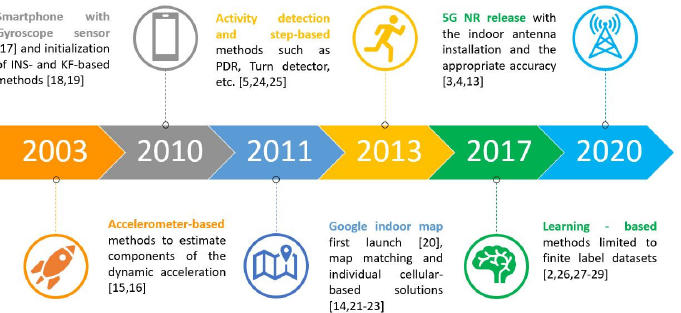
Figure 1. The timeline of smartphone-based positioning techniques obtained from extensive literature review [15–29].